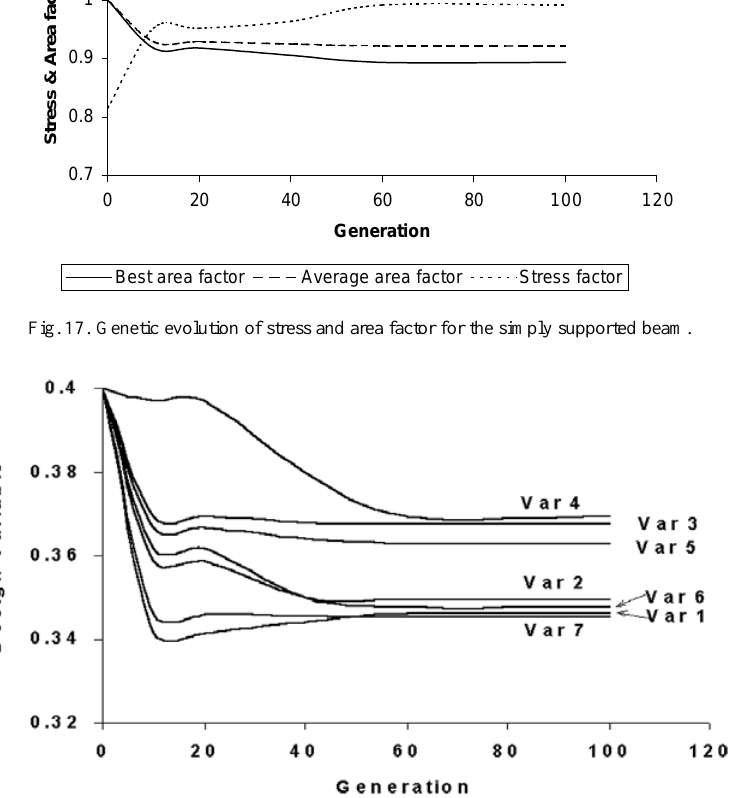
Fig. 18. Design variables vs. generations for simply supported